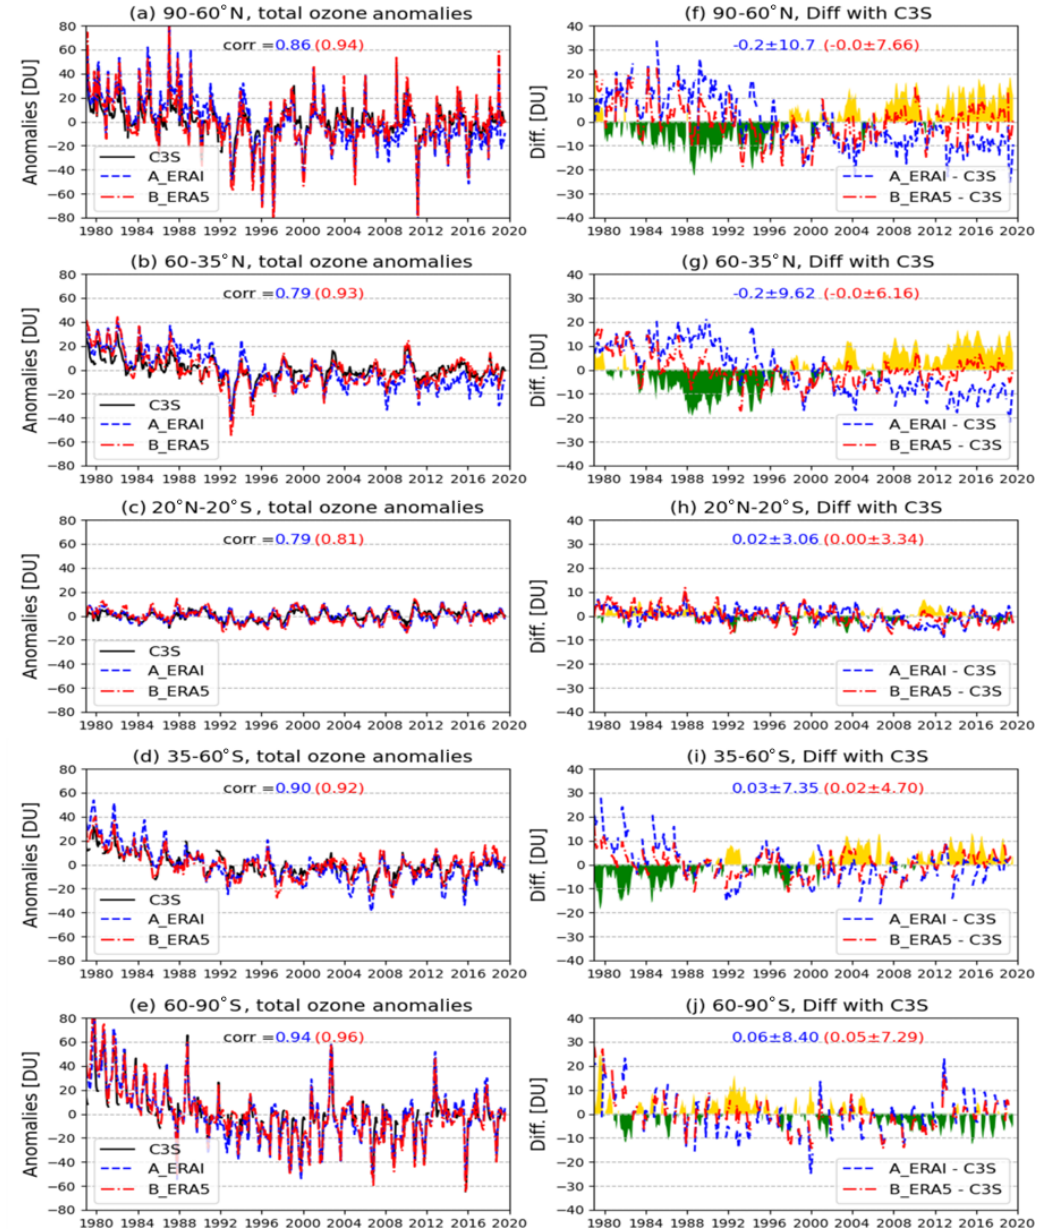
Figure 1. (a–e) Monthly mean total column ozone (TCO) anomalies (DU) derived from C3S (black solid line) and TOMCAT simulations A_ERAI (blue dashed line) and B_ERA5 (red dash-dotted line) over 1979–2019 (August) for the following five latitude regions: 90–60 ◦ , 60–35 ◦ N, 20 ◦ N–20 ◦ S, and 35–60 ◦ and 60–90 ◦ S. (f–j) Absolute differences in TCO between each simulation and C3S (blue dashed line for A_ERAI–C3S and red for B_ERA5–C3S) and between the two simulations (B_ERA5–A_ERAI, shaded with green for B_ERA5 < A_ERAI and yellow for B_ERA5 > A_ERAI). Correlation coefficients and TCO differences with standard deviations between simulation A_ERAI (B_ERA5) and C3S are shown with blue (red)